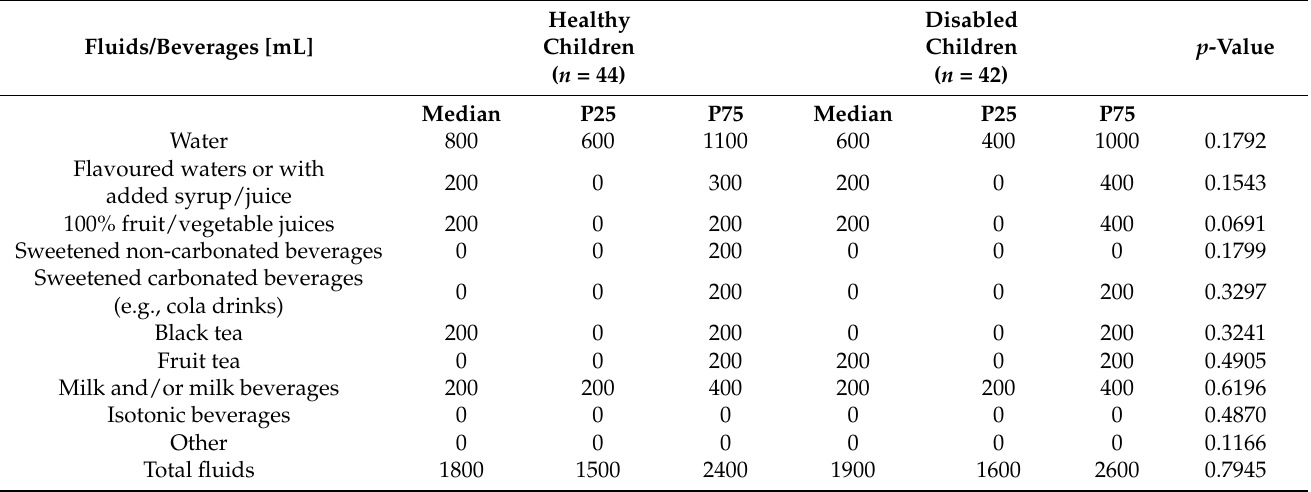
Table 4. Declared amount of beverages consumed [ml] per day, taking into account healthy and disabled children.